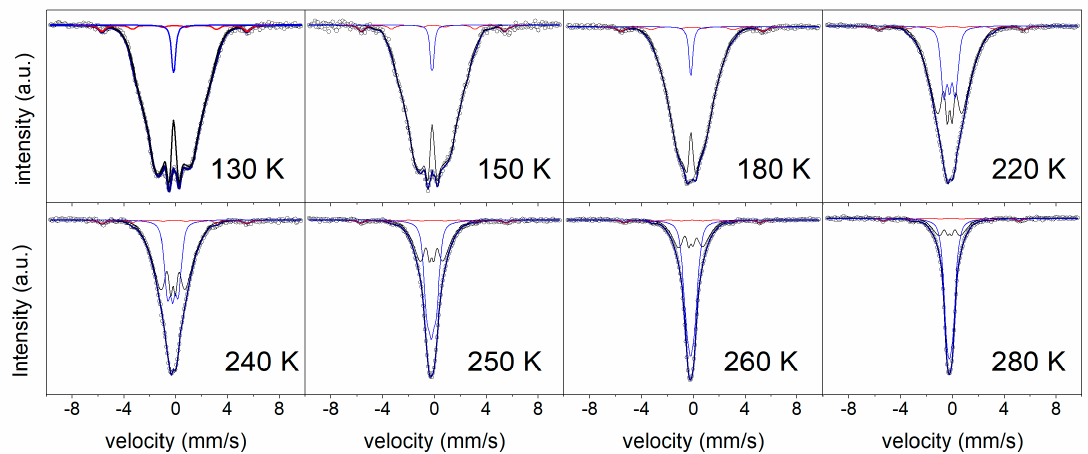
Figure 3. Mössbauer spectra of the sample after 50 h of milling, collected at different temperatures. The symbols correspond to the experimental data. Blue, black, and red subspectra correspond to Fe atoms in the paramagnetic, ferromagnetic, and α -Fe phases, respectively.